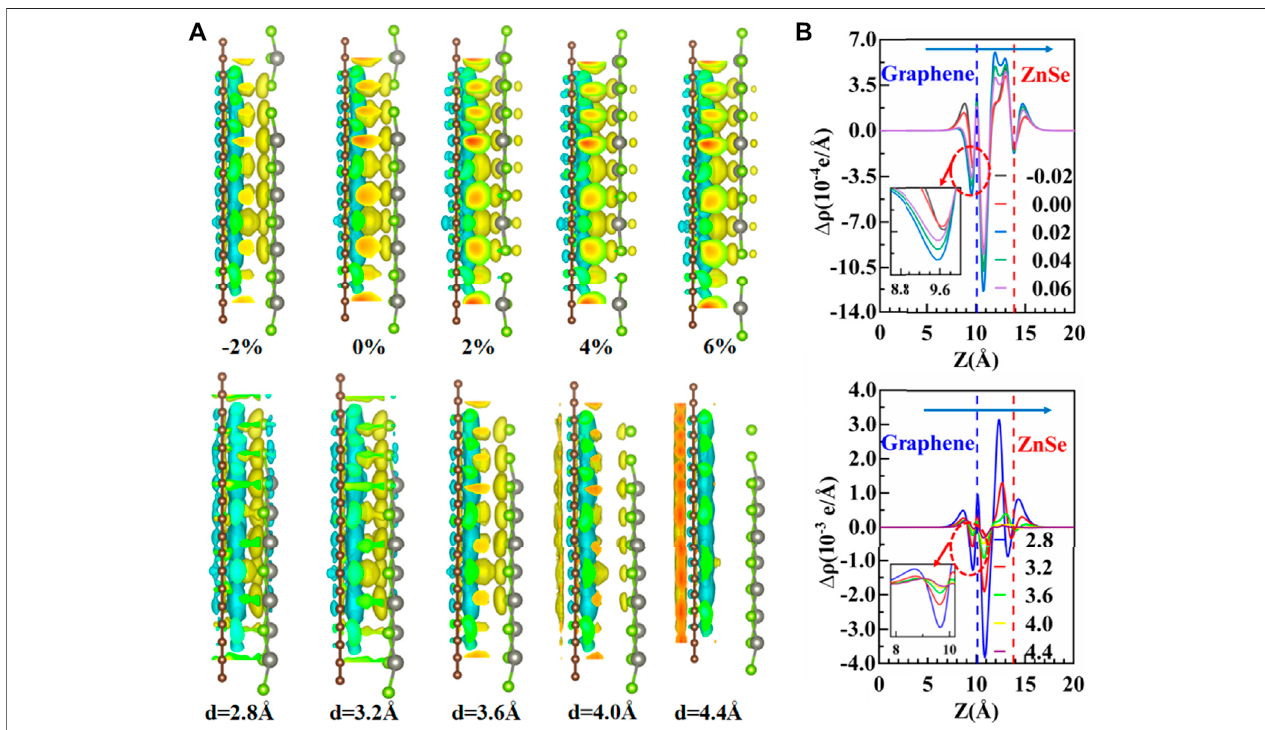
FIGURE 5 | (A) On behalf of the charge density difference of the graphene/ZnSe system under different horizontal strains and vertical strain, yellow and cyan represent the accumulation and depletion of electrons, respectively. (B) PCDD under horizontal strain and vertical strain.